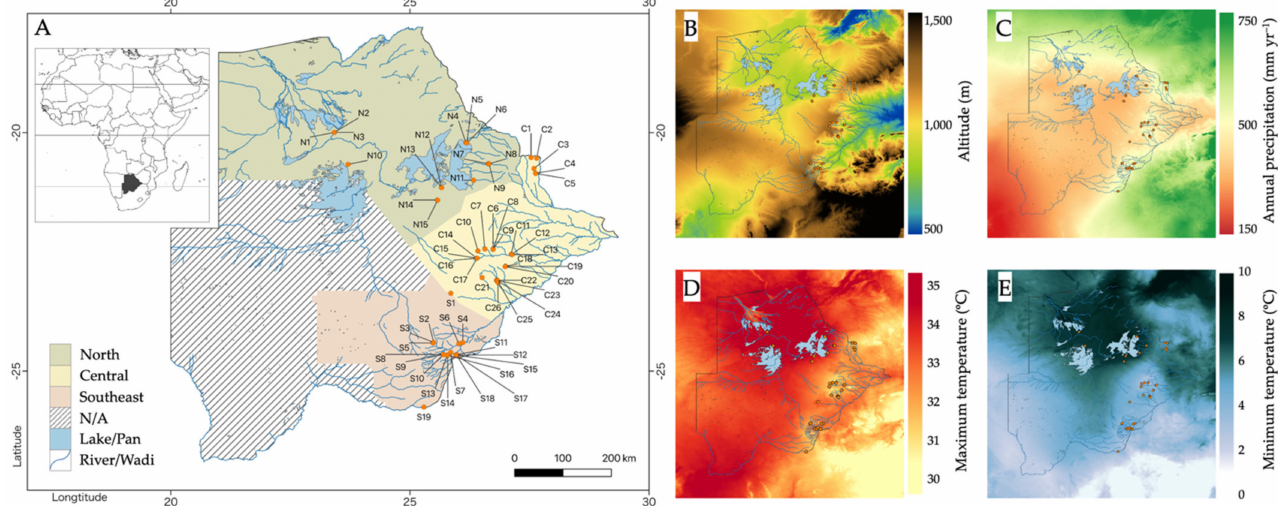
Figure 1. Geographic distribution of Jatropha accessions and environmental factors in Botswana. ( A ) The collection sites of Jatropha accessions analyzed in this study are indicated by orange dots, with their accession IDs, on a map of Botswana. Color legend for the three geographical areas (North, Central, and Southeast) adopted in this study is indicated in the bottom left corner. N.A. represents a region where Jatropha trees were not available. Inset in the top left corner denotes the location of Botswana on the African continent. ( B ) The altitude, ( C ) annual precipitation, ( D ) maximum temperature of the hottest month, and ( E ) minimum temperature of the coldest month in